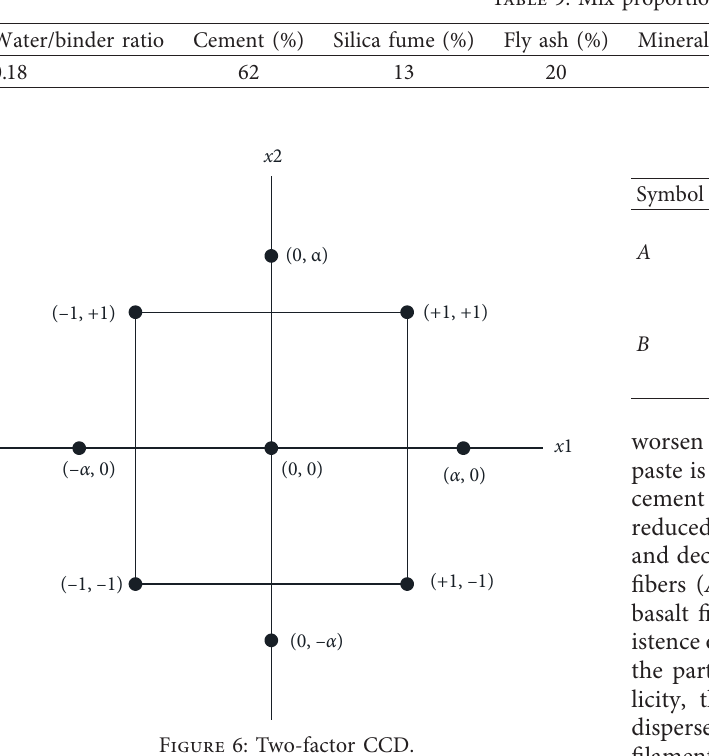
Table 9: Mix proportion.